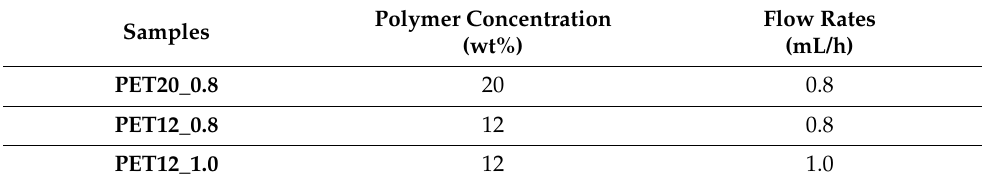
Table 1. Operating parameters for